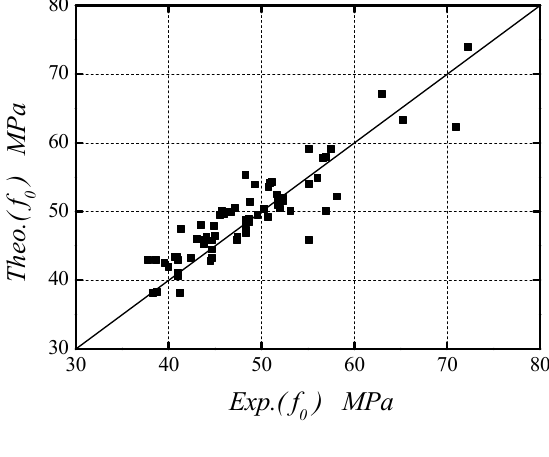
Figure 10. Theo.( f 0 ) vs. Exp.( f 0 ).